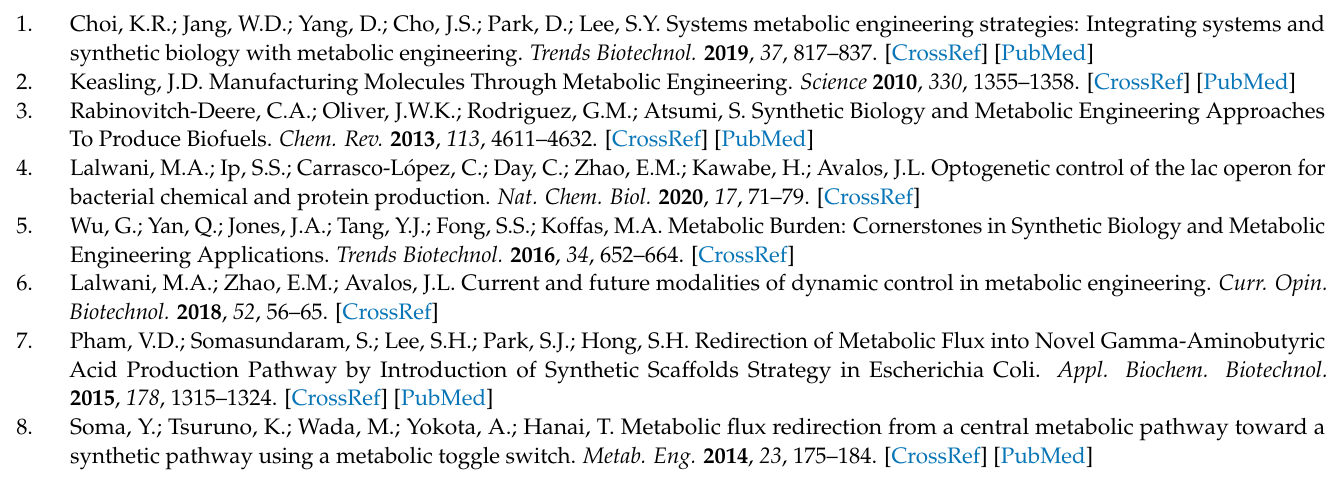
Figure S1: The relative fluorescence of different type of CcaS-CcaR; Figure S2: The modification of endogenous CRISPRi system; Figure S3. sgRNA sequence targeting gltA ; Figure S4: The regulation effect of different copy-number in light-controlled